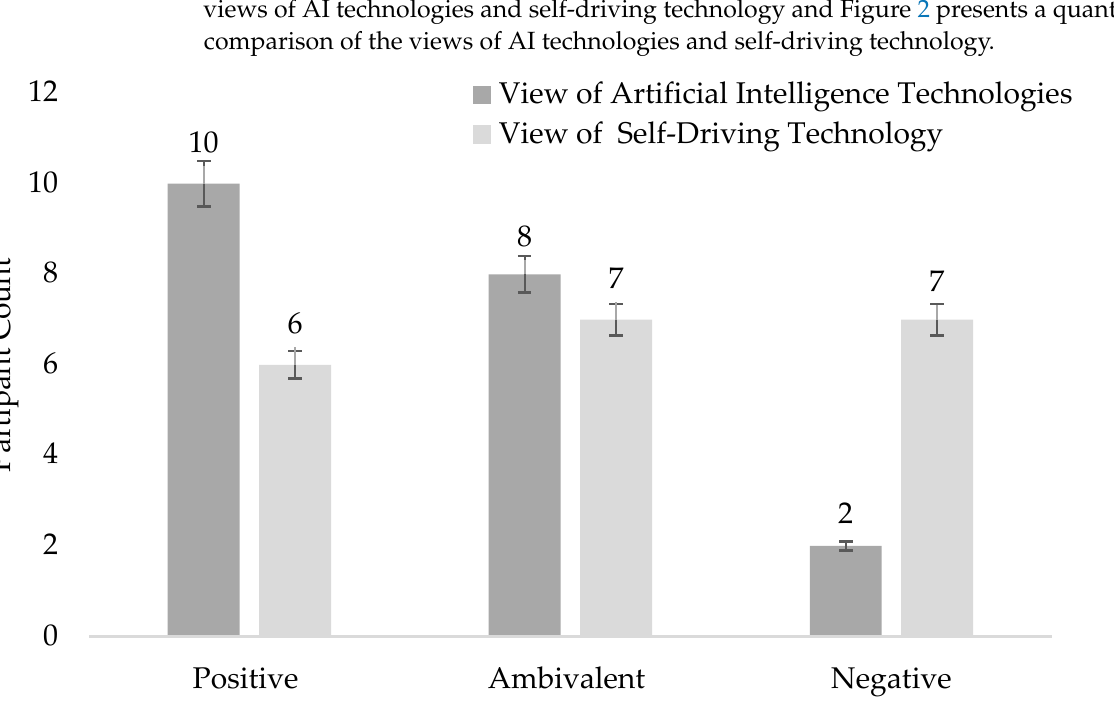
Figure 2. Views of AI Technologies and Self-Driving Technology.